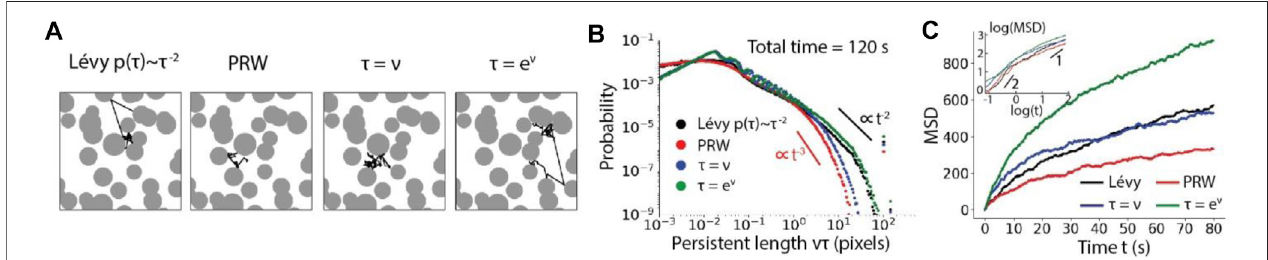
FIGURE 9 | Particle motility in fl uenced by the moving strategies in a convex porous environment. (A) , Example trajectories of Lévy walk, PRW, linear RWSP and nonlinear RWSP re fl ected by the circular obstacles. (B) , The distribution ofthe persistent length, whose tails are approximated by power laws withcutoff at largevalues. (C) , MSD curves over time. The particle motion is superdiffusive at short times and subdiffusive at long times.